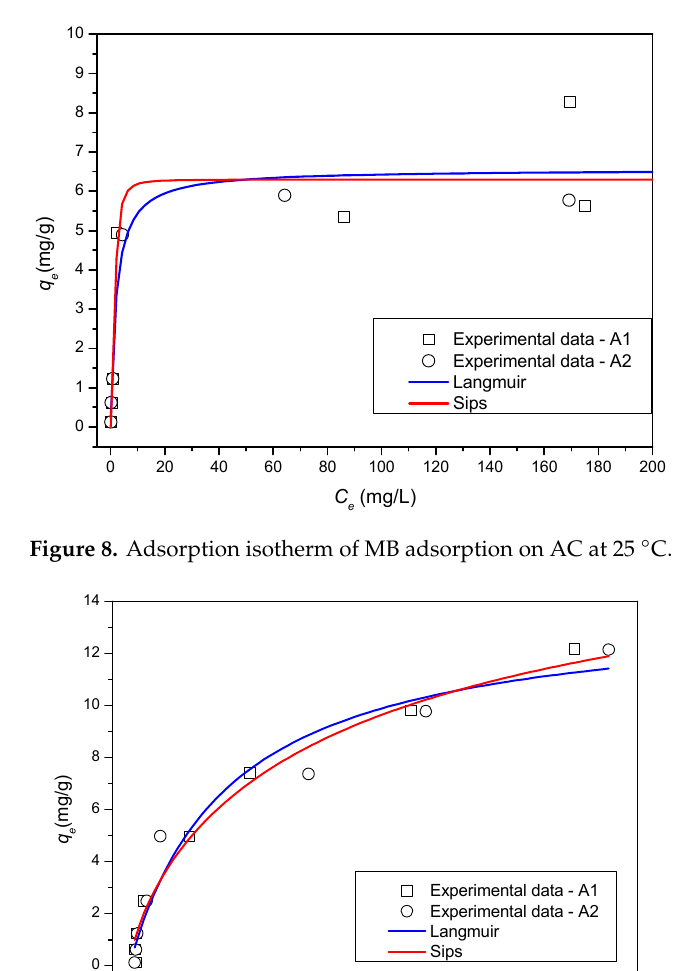
Figure 9. Adsorption isotherm of MB adsorption on ASC at 25 °C. Table 3. Isotherm parameters for MB adsorption onto AC and ASC at 25 °C.